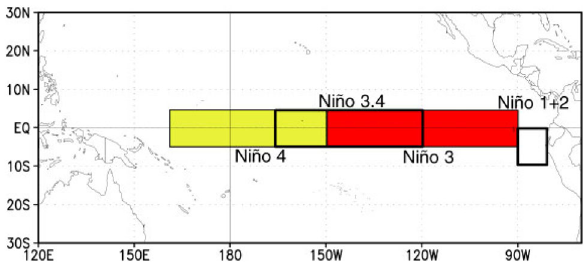
Fig. 2 Map of Nin˜o regions across the tropical Pacific Ocean. Source : NOAA